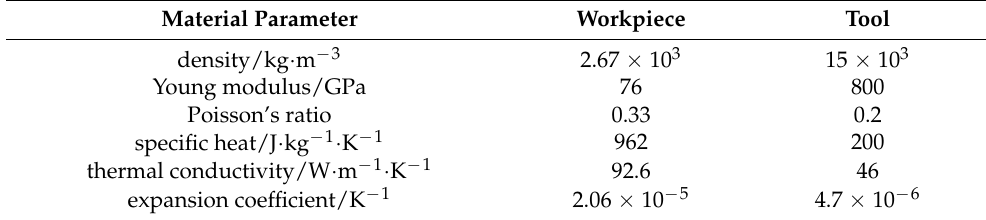
Table 2. The material parameters of ADC12 aluminum alloy and cemented carbide tool.